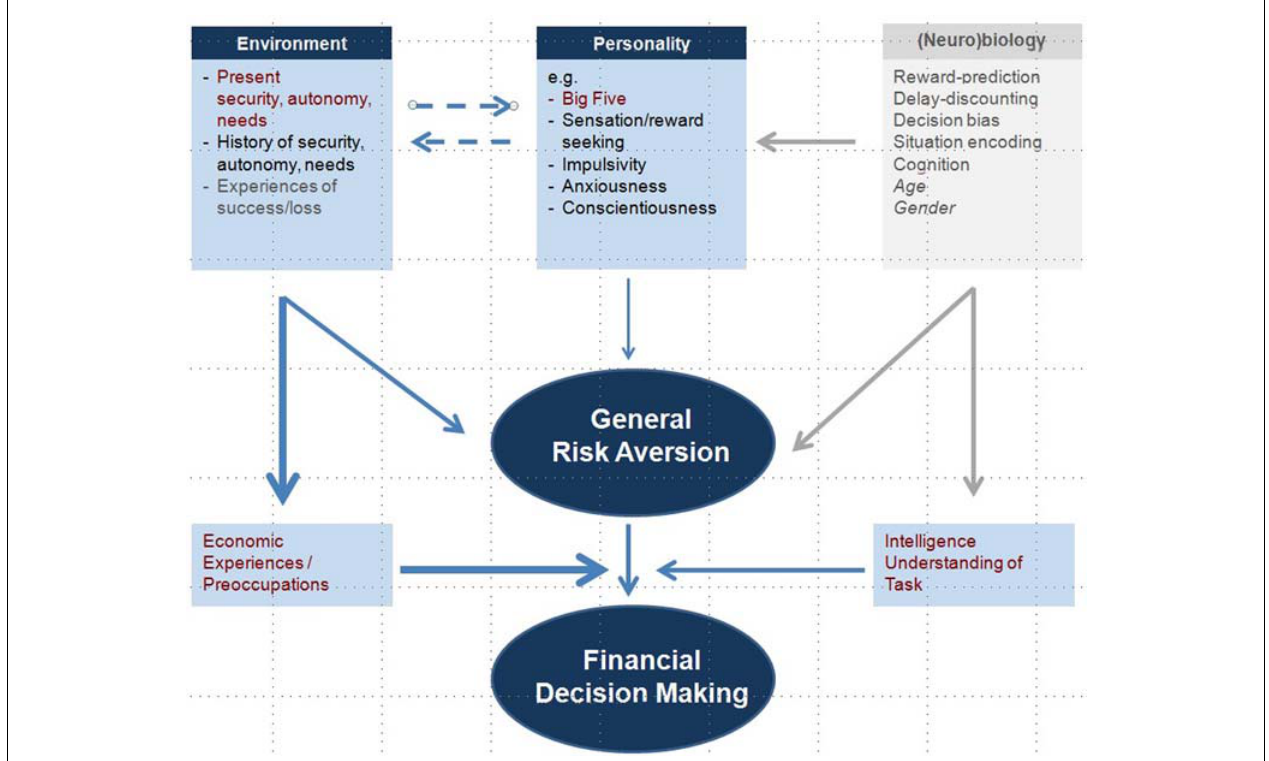
economic experiences. Furthermore, economic preoccupations as well as cognitive performance can independently affect the financial decision making process. (Factors and causalities in gray color depict reasonable associations which were, however, not subject to the present